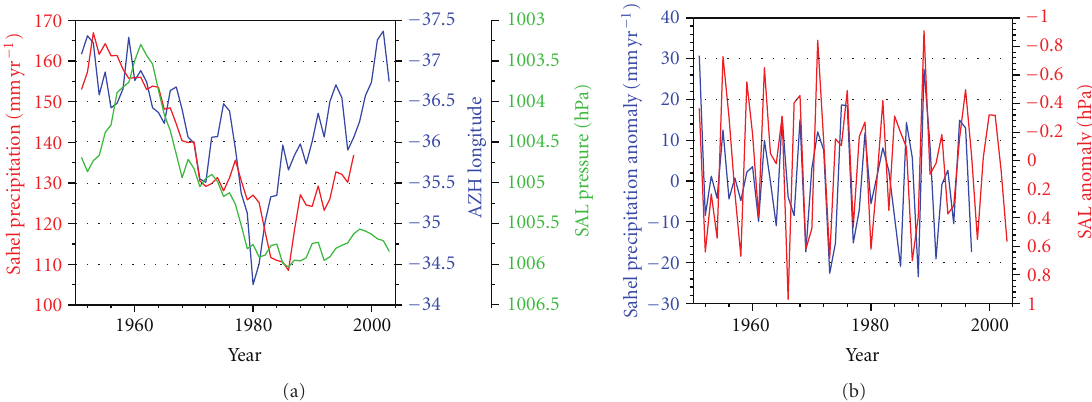
Figure 3: (a) 5-year moving averages: Sahel precipitation (red), AZH longitude (blue), and SAL pressure (green, its axis has been inverted in the figure to facilitate comparison with Sahel precipitation). (b) Sahel precipitation anomalies (blue) and SAL pressure anomalies (red).